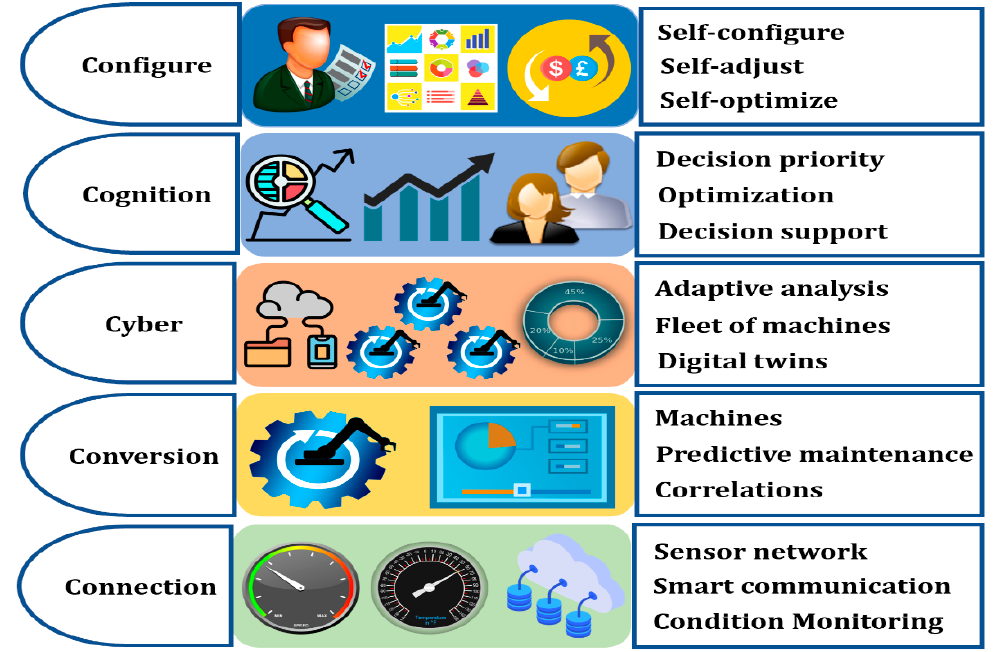
Figure 9. Techniques and levels of the 5C (connection, conversion, cyber, cognition, and configuration) architecture for cyber-physical systems (CPS).